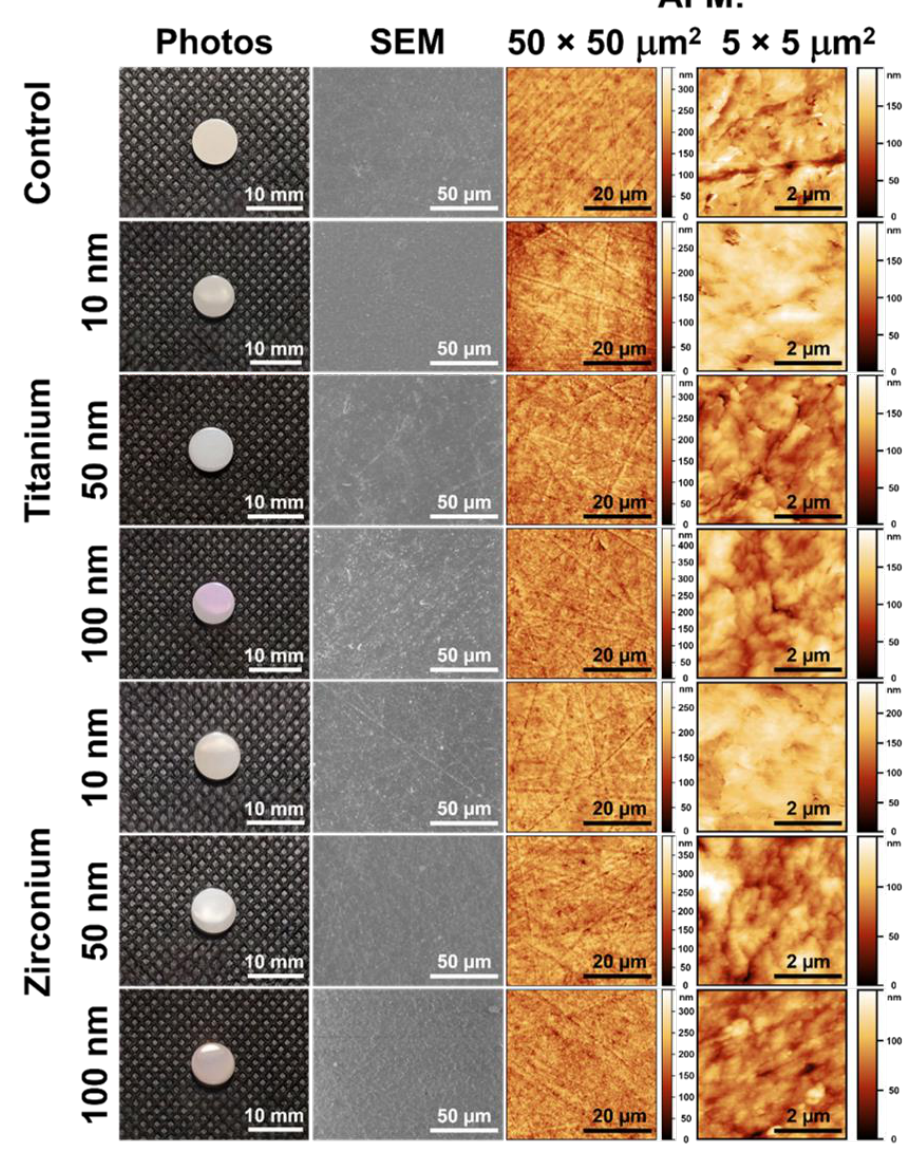
Figure 2. Photographs of the macroscopic appearance of all investigated sample surfaces (first column), SEM micrographs (second column), AFM micrographs of a surface area of 50 × 50 µ m 2 (third column) and AFM micrographs of a surface area of 5 × 5 µ m 2 (fourth column). The control sample is an unmodified PEEK sample surface and serves as a reference, the other samples are surface-modified with Ti and Zr coatings in thicknesses of 10, 50 and 100